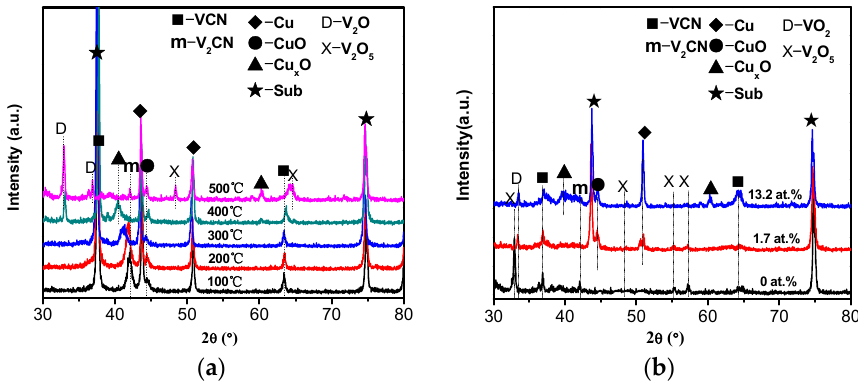
Figure 9. XRD patterns of VCN–13.2 at.% Cu composite films after sliding ( a ) at different temperatures and ( b ) VCN–Cu composite films after sliding at 500 °C.